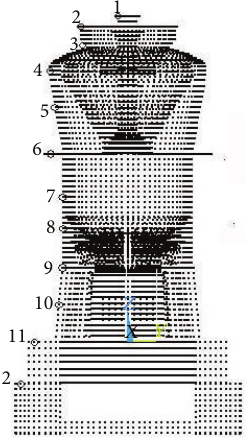
Figure 4: Placement of candidate measuring points. Table 3: Optimization results of measuring points.